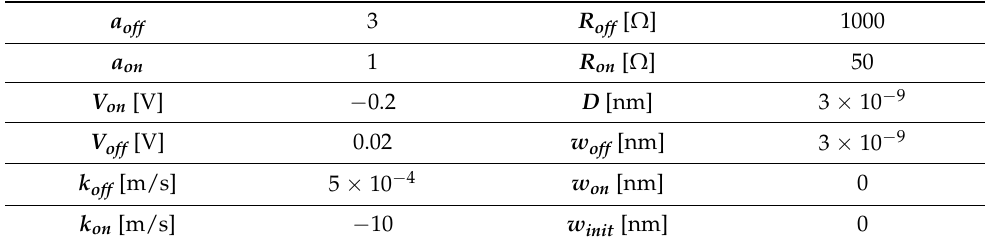
Table 1. The VTEAM model parameter used in setup circuit for simulation.